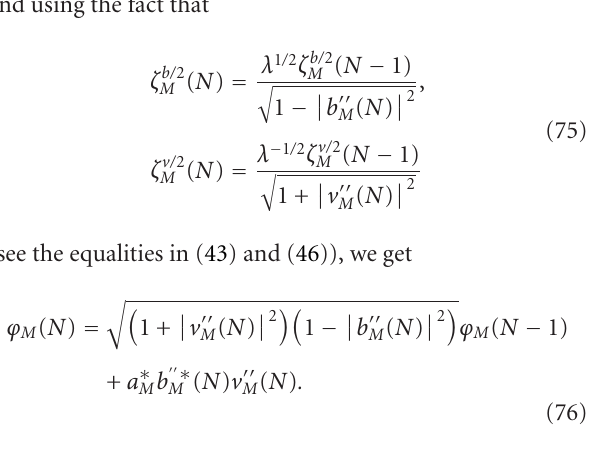
Algorithm 4 is the resulting normalized extended RLS lattice algorithm. For compactness of notation and in order to save